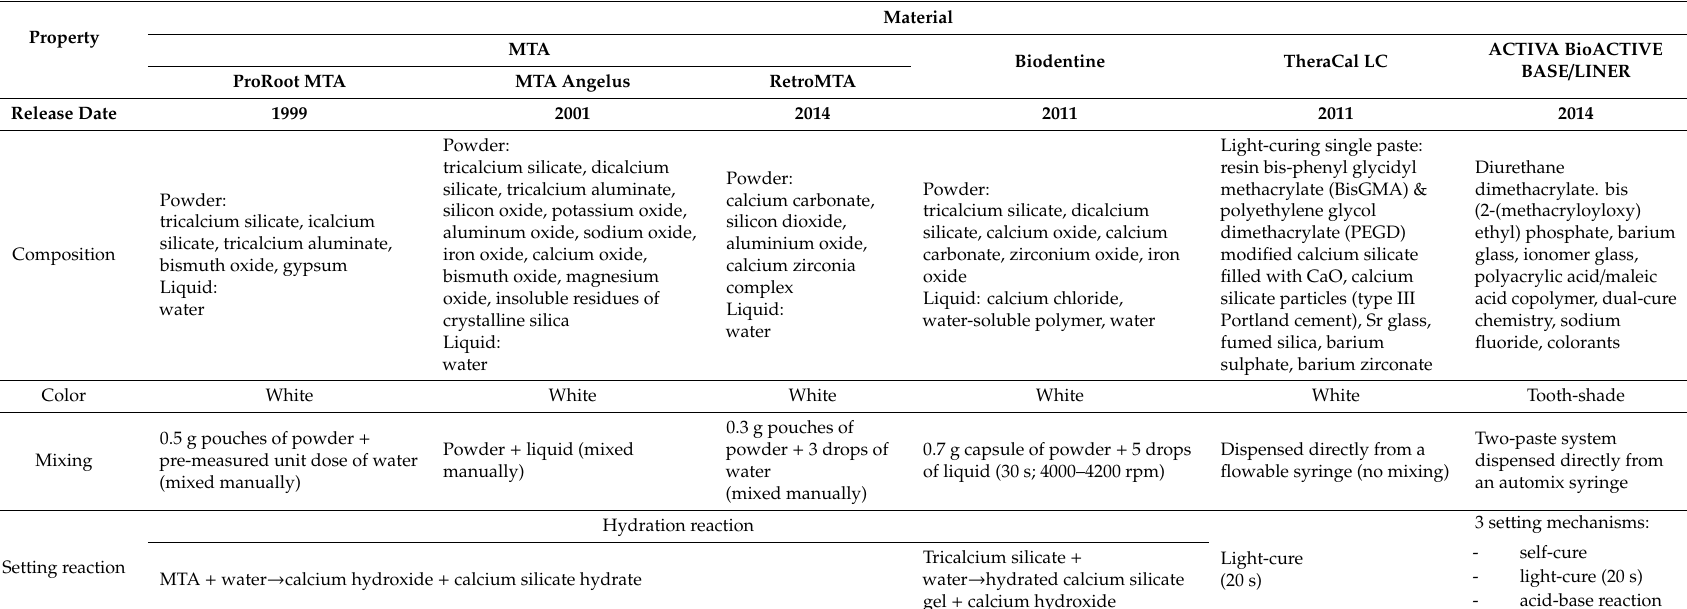
Table 1. General information on pulp capping